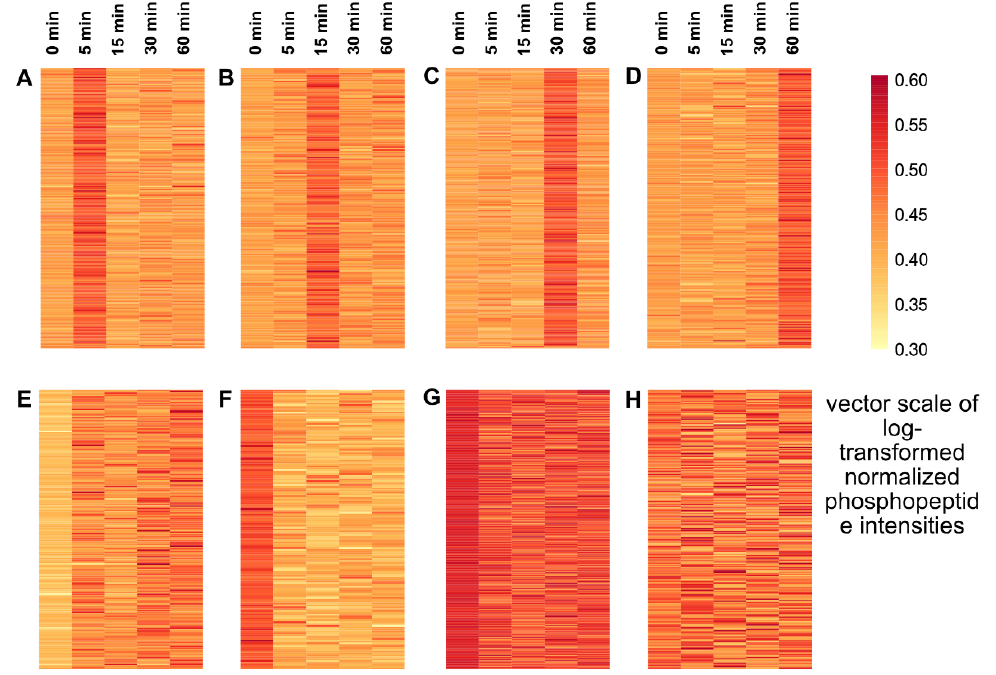
Figure 2. K-means clusters in the time-course analysis of phosphopeptide intensities in response to cold. Clusters are positioned based on their similar time-based characteristics. ( A )